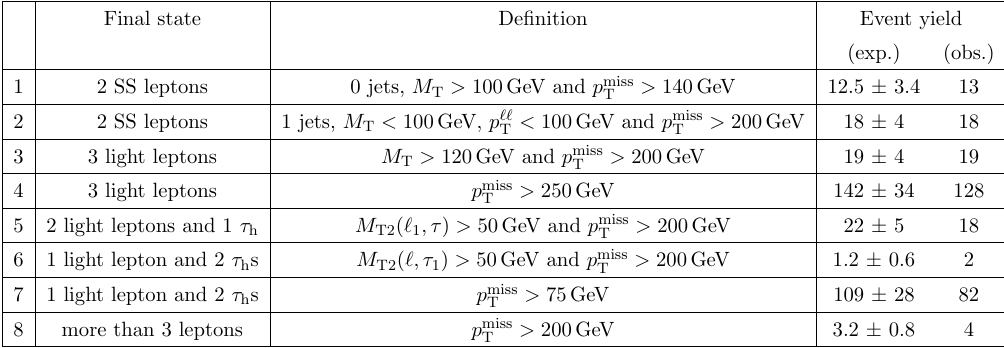
Table 19 . Expected and observed yields in the aggregated signal regions de(cid:12)ned in section 5.3. For each bin, the (cid:12)rst number corresponds to the expected yield (exp.) and its uncertainty, and the second denotes the observed yield (obs.). The uncertainty denotes the total uncertainty in the